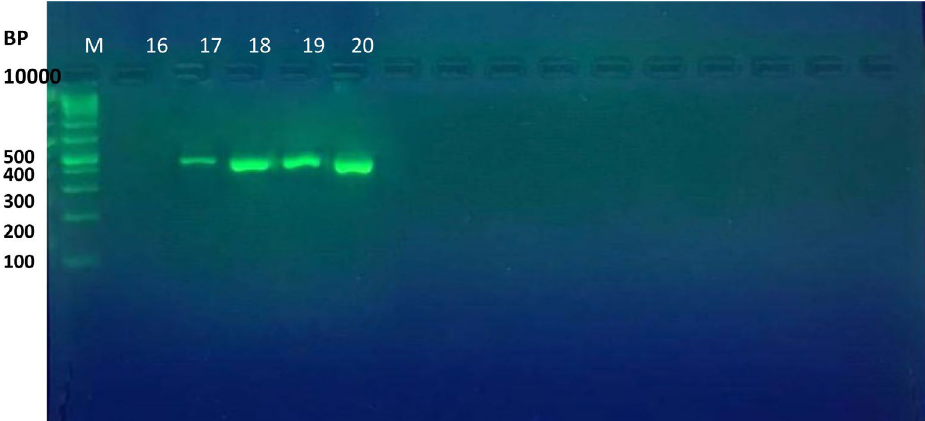
Fig. 2. Gel electrophoresis of PCR product of CTX-M gene in K. pneumoniae isolates, M= DNA molecular size markers (100 bp), 16 to 20 represents number of isolates, 1% agarose gel at 5 Vol /cm for 1:15